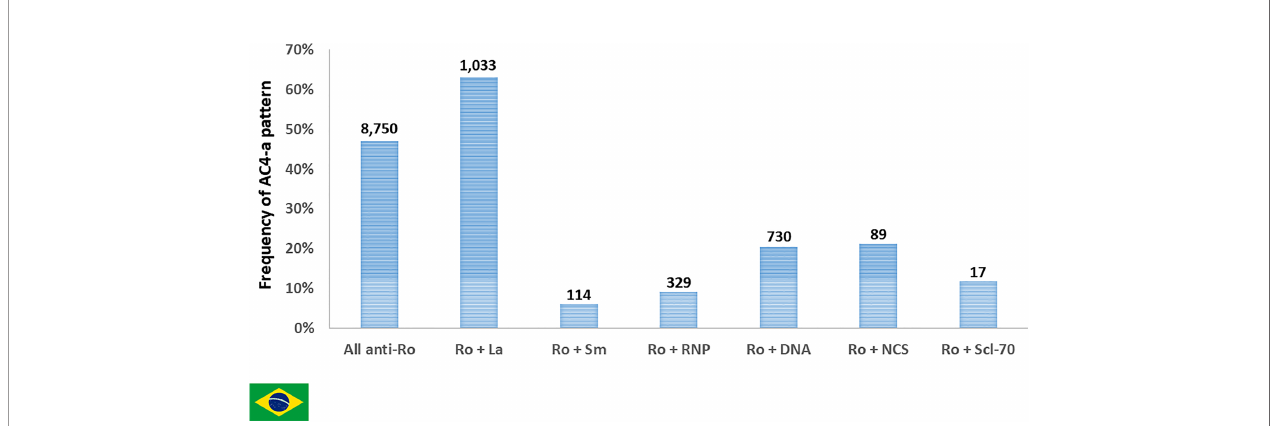
FIGURE 8 | Frequency of pattern AC-4a in samples reactive with Ro60 and other autoantibodies according to data from Fleury Laboratory, São Paulo, Brazil. A nested cohort of 2,312 Ro60-positive samples had antibodies to one additional DAA (SS-B/La, dsDNA, nucleosome/chromatin, Sm, U1-RNP, or Scl-70). The frequency of samples presenting the AC-4a pattern is depicted for the combinations of SS-A/Ro and each autoantibody. Absolute numbers in each category are shown at the top of